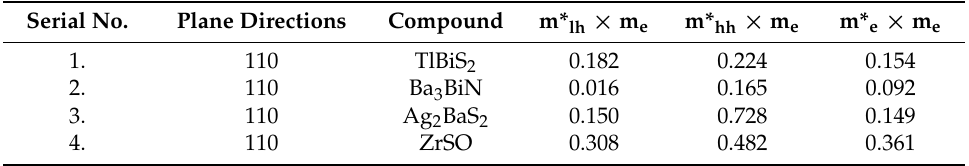
Table 2. The calculated effective mass of non-silicon compounds. m* lh , m* hh and m* e are the effective masses of light holes, heavy holes and electrons, respectively. m e is the mass of the electron. Serial